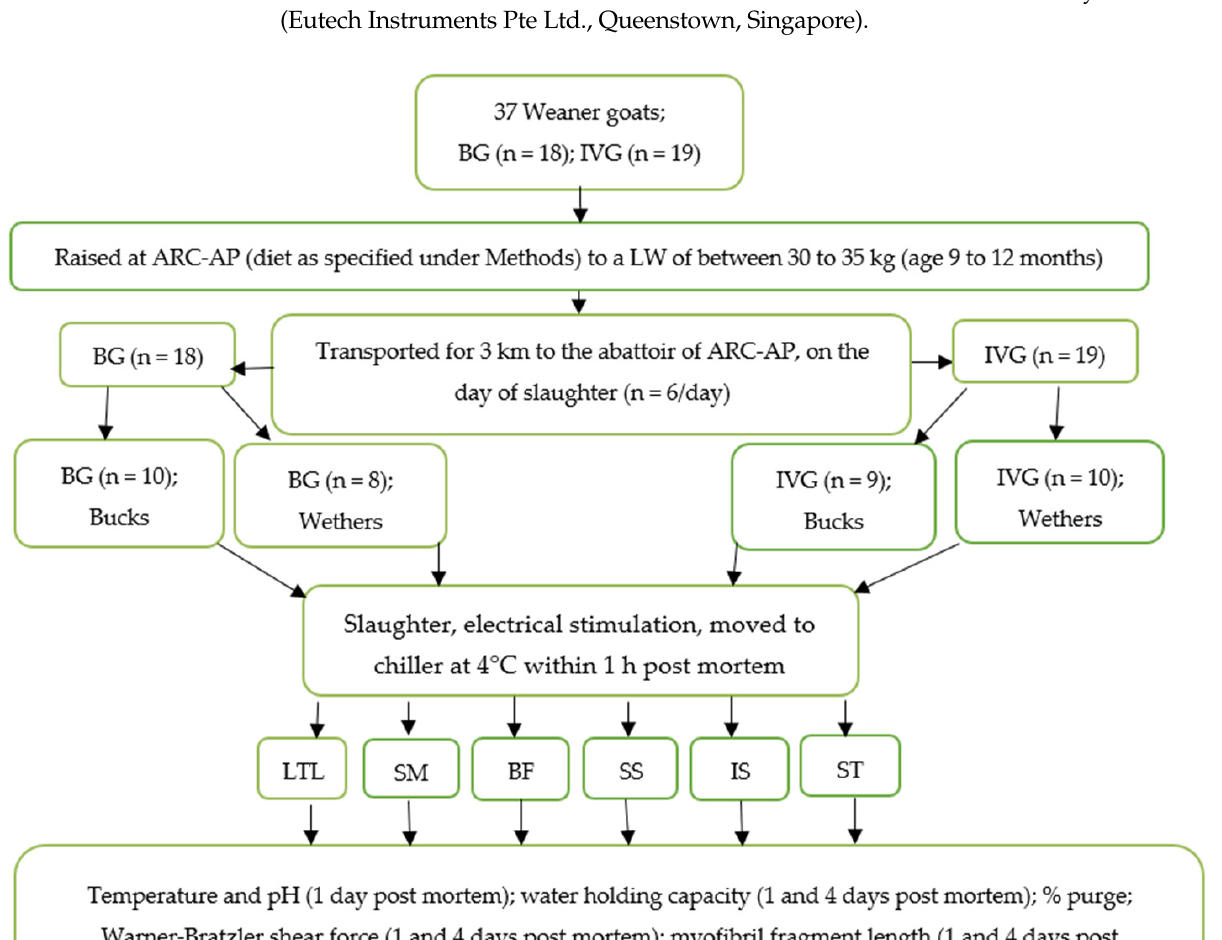
Figure 1. Experimental design to evaluate the effect of the breeds large-frame Indigenous Veld Goat (IVG, Cape Speckled and Cape Lob Ear) and Boer Goat (BG) of southern Africa, on tenderness factors, colour attributes and connective tissue characteristics of Longissimus thoracis et lumborum (LTL), Semimembranosus (SM), Biceps femoris (BF), Supraspinatus (SS), Infraspinatus (IS), and Semitendinosus (ST). ARC-AP = Agricultural Research Council-Animal Production, Irene, South Africa.